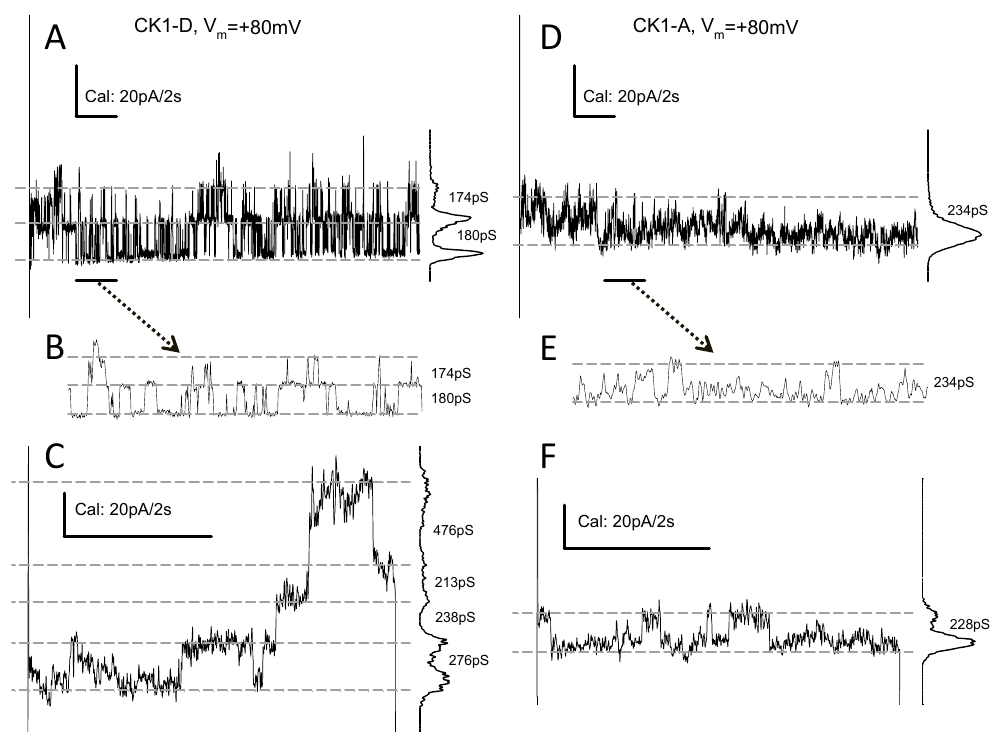
Figure 5. Cx43-CK1-D and Cx43-CK1-A expressing cells display frequent connexin HCh activity. Plasma membrane channel transitions compatible with opening of undocked connexons from single cells expressing Cx43-CK1-D ( A – C ) or Cx43-CK1-A ( D – F ). Lines, marks, plots, and numbers as in Figure 2. ( A , D ) are 20 s samples of longer recordings; ( B , E ) are expanded displays of the 2 s interval marked by black lines at the bottom left of ( A , C ); ( C , F ) Further examples of transitions recorded during 5-s pulses. Hemichannel activity from Cx43-CK1-D is usually well defined (as in A – C ), in contrast to Cx43-CK1-A ( D – F ).